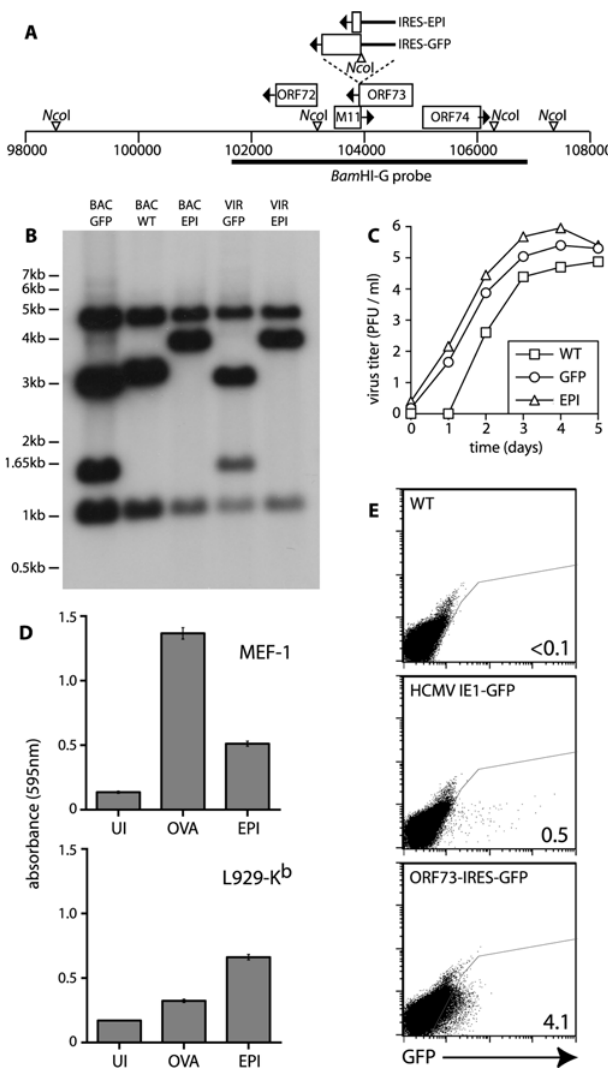
Figure 3. Modification of the MHV-68 Genome to Overcome cis- Acting Immune Evasion by ORF73 (A) An IRES element was inserted just downstream of ORF73, between its stop codon and that of M11. This allowed either